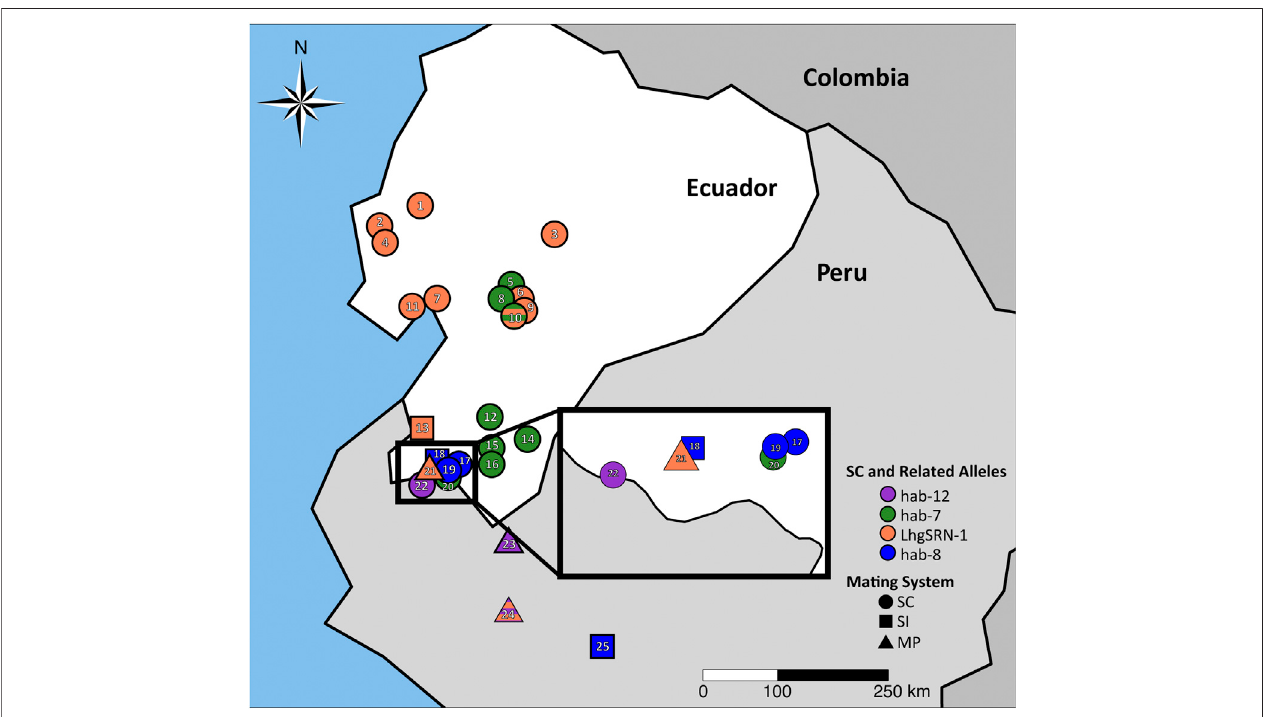
FIGURE4| SC-associated S-RNase alleles and ancestral SI-associated S-RNase alleles in S.habrochaites at thenorthern species margin. Allelesassociatedwith self-compatibility (SC) are found in SC populations (circles), and their related putatively ancestral alleles are found in segregating SI (square) or SI/SC mixed populations (MP,triangles).ColorsrepresentdifferentiatedpopulationsasdescribedinLandisetal.,2021.Forakeytoaccessionsdisplayedsee SupplementaryTableS4 .Orange (cid:1) LhgSRN-1 or LhgSRN-1-like alleles(SC-2),green (cid:1) hab-7 allele(SC-1),stripedorange/green (cid:1) segregating LhgSRN-1 and hab-7 allelesinaregionofSC-1/SC-2 hybridization, blue (cid:1) hab-8 or hab-8-like alleles (SC-5), purple (cid:1) hab-12 or hab-12-like alleles (SC-7). LhgSRN-1-like alleles are also found in SI or MP populations in central Peru ( Supplementary Table S4 ).